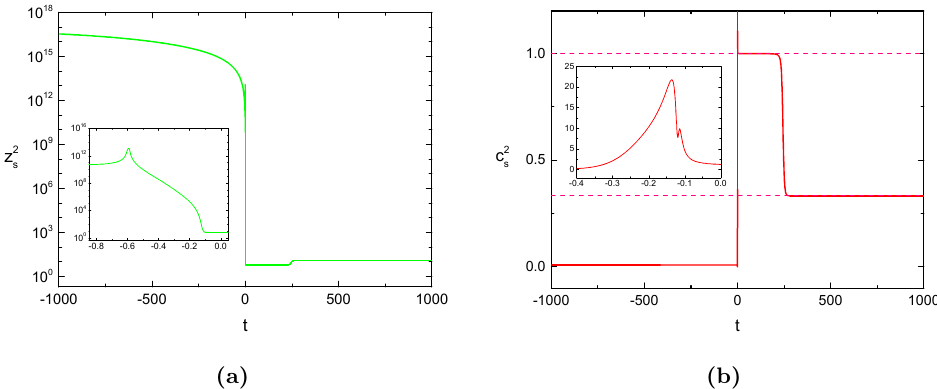
(the solid green curve in the left panel) and c 2 (the solid red curve in s s and c 2 is explicitly illustrated. s s , which equals 1 shortly after the genesis and turns s